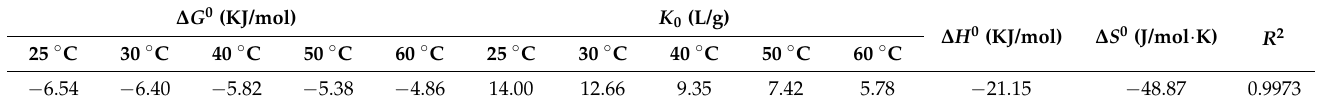
Figure 10. Experimental data from the adsorption of AO7 onto porous CeO 2 fitted using the Van’t Hoff equation ([CeO 2 ] = 2.0 g/L; [AO7] = 150 mg/L; V = 100 mL; t = 60 min; 200 rpm; Room tempera ‐ ture; No pH preadjustment).